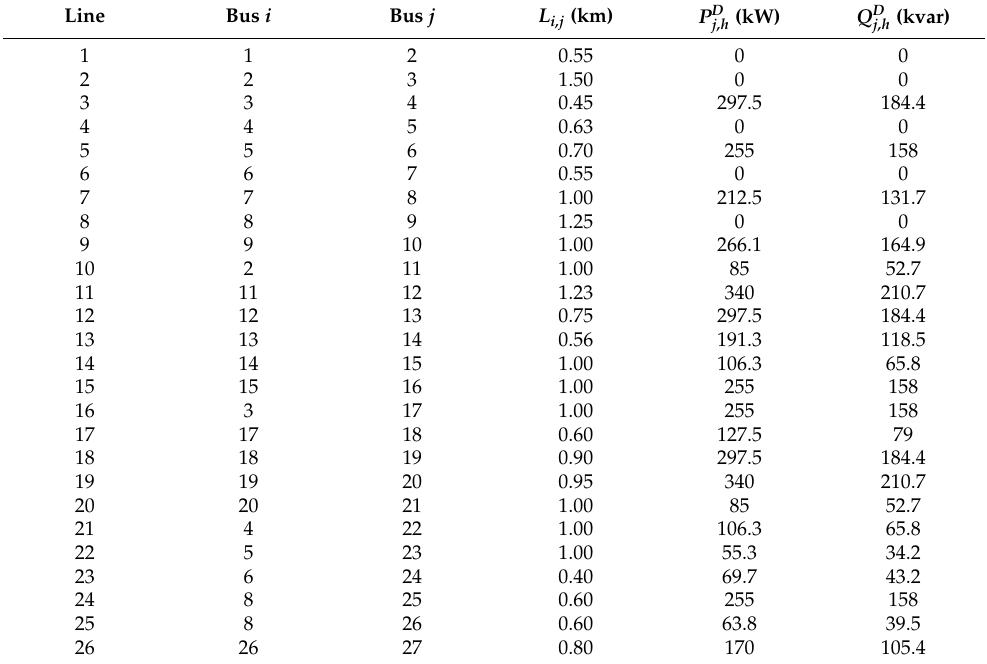
Table 6. Information corresponding to the 27-bus test system for the balanced case.